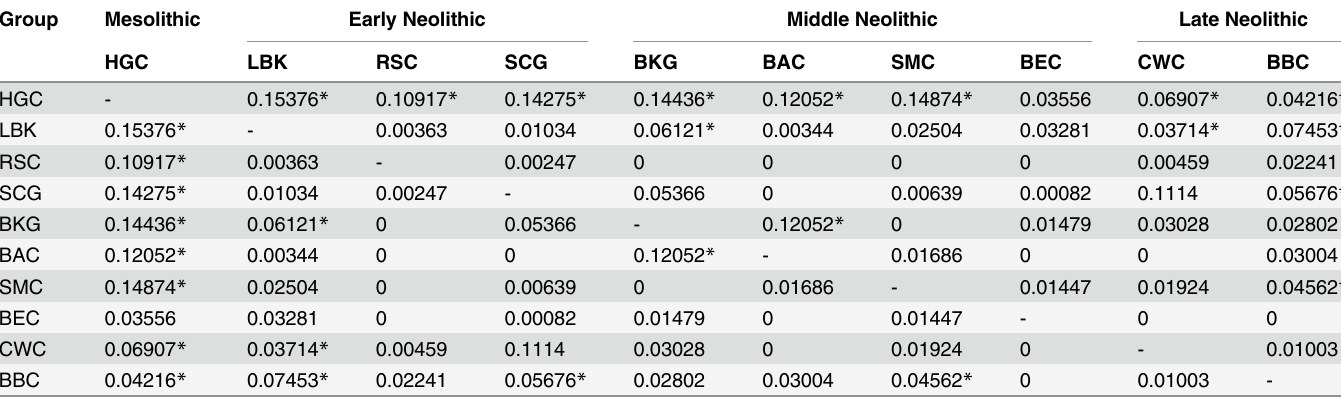
Table 2. F ST distances between Mesolithic and Neolithic groups from central Europe based on HVR-I mtDNA sequence (abbreviations are listed in the legend of the Table). Group